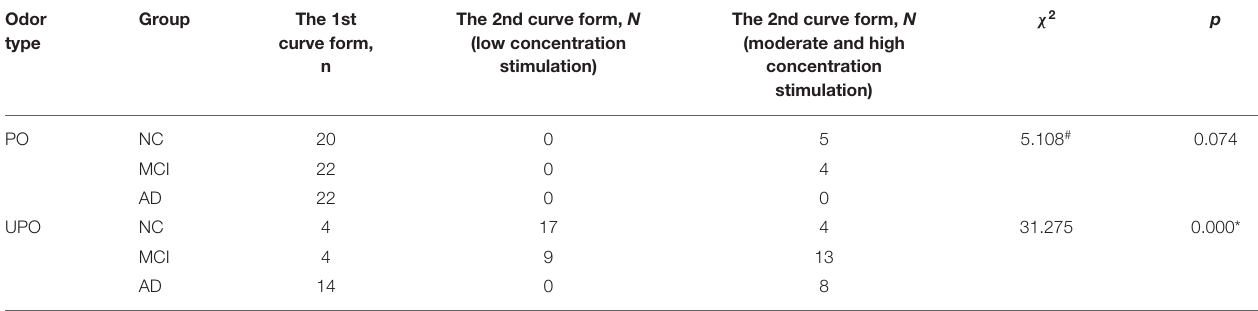
TABLE 1 | The respiratory amplitude curve form of subjects among three groups under PO and UPO.